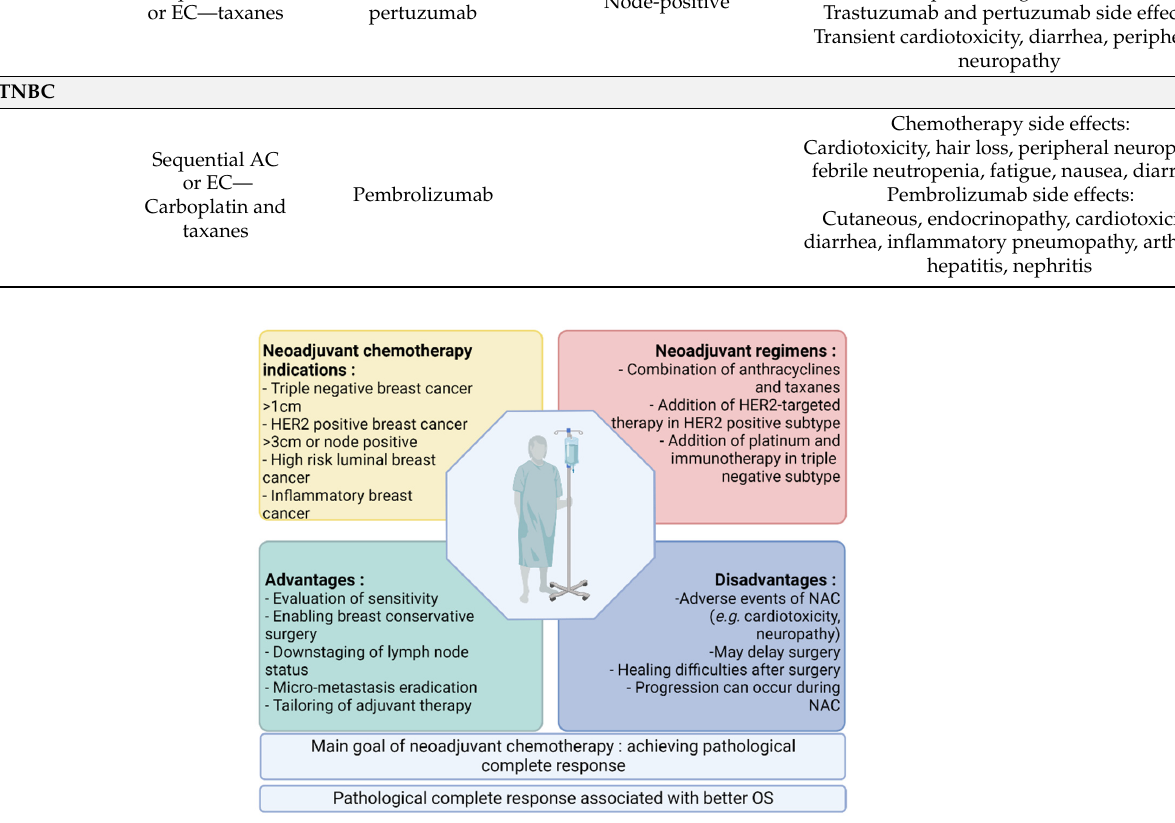
Figure 1. Overview of current indications, regimens, advantages and disadvantages of NAC. Table 1. Drugs used in NAC regimens in early breast cancer, indications and side effects. AC: dox- orubicin and cyclophosphamide; EC: epirubicin and cyclophosphamide; CMF: cyclophosphamide, methotrexate, 5-fluorouracile; TC: docetaxel and cyclophosphamide. Breast Cancer Subtype